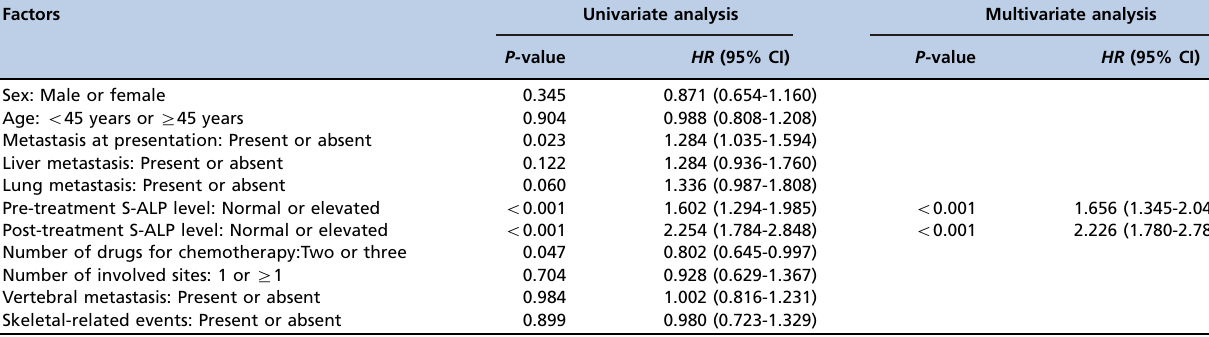
Table 2 - Univariate and multivariate analysis of progression-free survival. Factors Univariate analysis Multivariate analysis